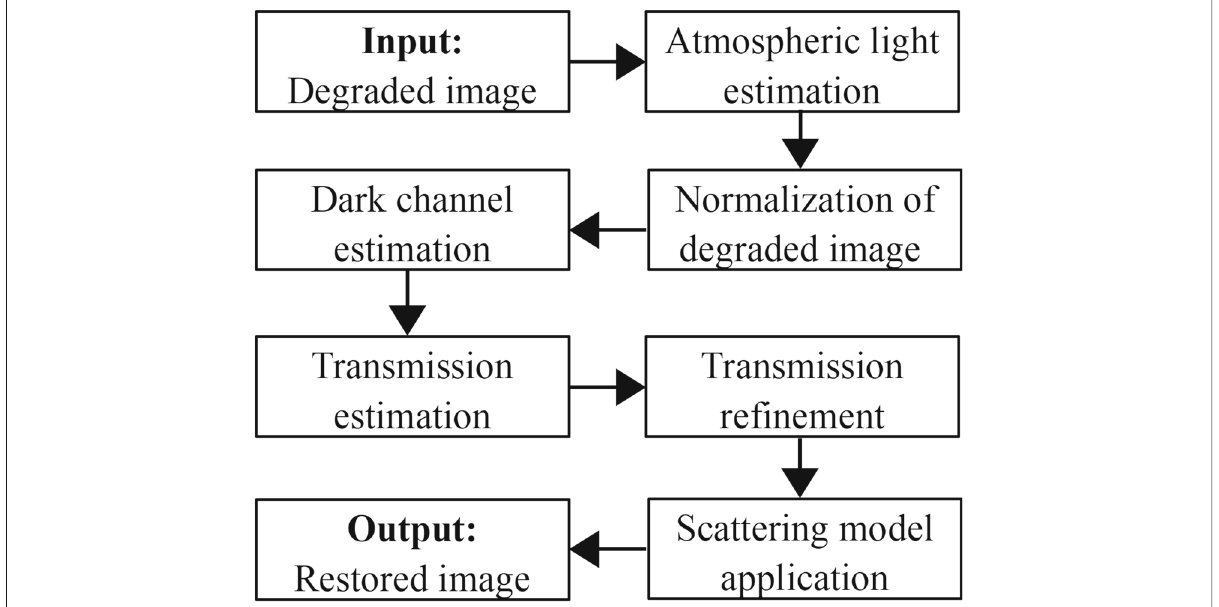
Fig. 2 Flowchart of the method based on the dark channel prior proposed in